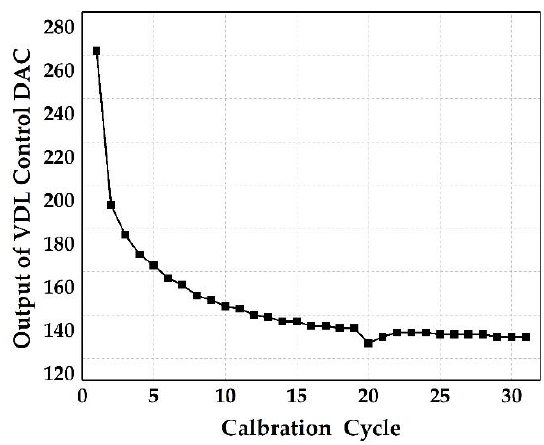
Figure 7. Simulated the calibration convergence with non-ideal 10 bit DAC based on proposed algorithm.